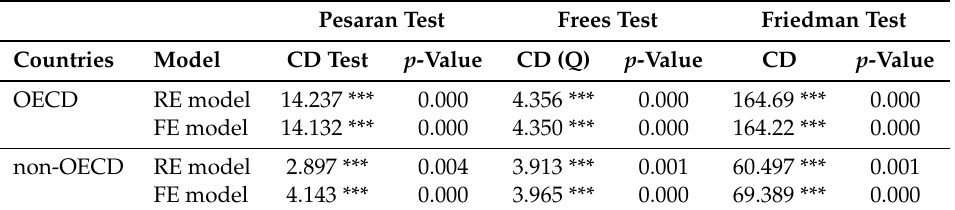
Table 3. Pesaran (2004); Frees (1995) and Friedman (1937) cross sectional dependence